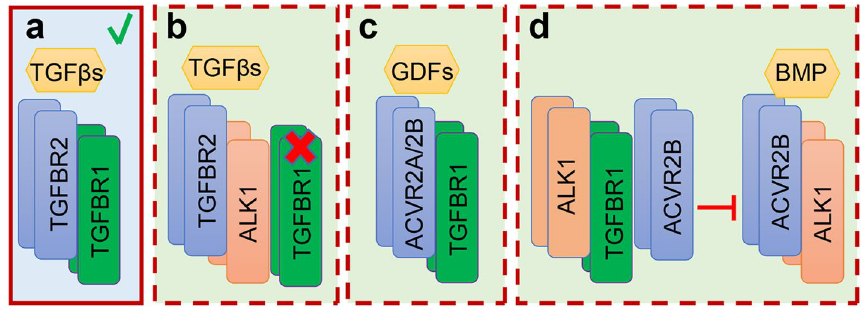
Figure 7. Contextually dependent TGFBR2/TGFBR1 signaling paradigms. ( a–d ) Potential modes of actions of TGFBR2 and TGFBR1 in different experimental systems. TGFBR2 is well known to complex with TGFBR1 to transduce signals by TGFβs ( a ). However, TGFBR2 may interact with other type 1 receptors (e.g., ALK1) in the absence of TGFBR1 to mediate TGFβ signaling that is detrimental to the homeostasis of aortic wall 15 ( b ). On the other hand, TGFBR1 may bind to receptors besides TGFBR2 (e.g., ACVR2B) to mediate growth differentiation factor (GDF) signaling during craniofacial development 18 ( c ). Moreover, TGFBR1 can interact with ALK1 and ACVR2B to suppress the formation of ACVR2B/ALK1 complex, thereby inhibiting BMP signaling 17 ( d ). Our studies using conditional deletion of Tgfbr2 , Tgfbr1 , and Tgfbr1/2 suggest the functional similarity between TGFBR2 and TGFBR1 in maintaining the developmental integrity of the female reproductive tract ( a